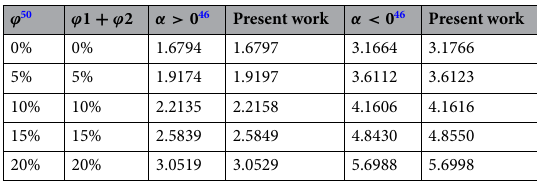
Table 9. Comparison of Nusselt number at lower porous wall with results published by Kashif et al. 46 against ϕ and α .